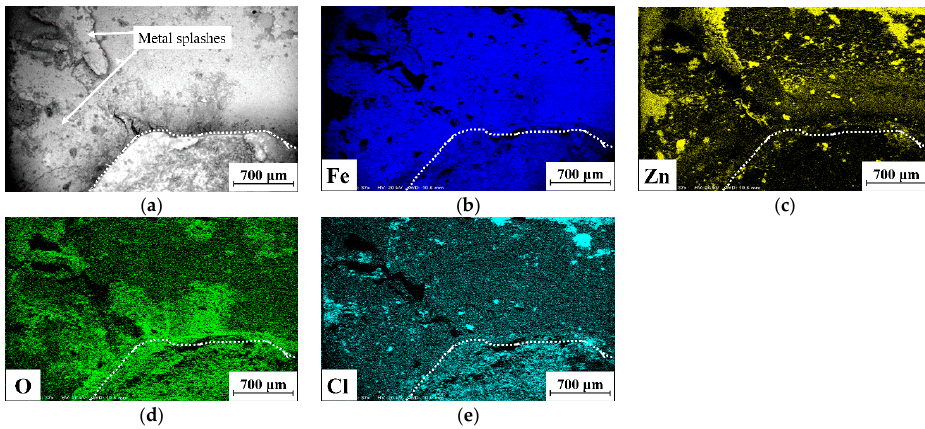
Figure 12. ( a ) SEM micrograph (BSE mode) on weld spot surface and surrounding HAZ of sample no. 4 after the salt spray exposure test. Chemical distribution of elements ( b ) Fe, ( c ) Zn, ( d ) O, and ( e ) Cl, as obtained from EDS analysis. White dotted lines point out the border of the fractured spot weld by pull out.